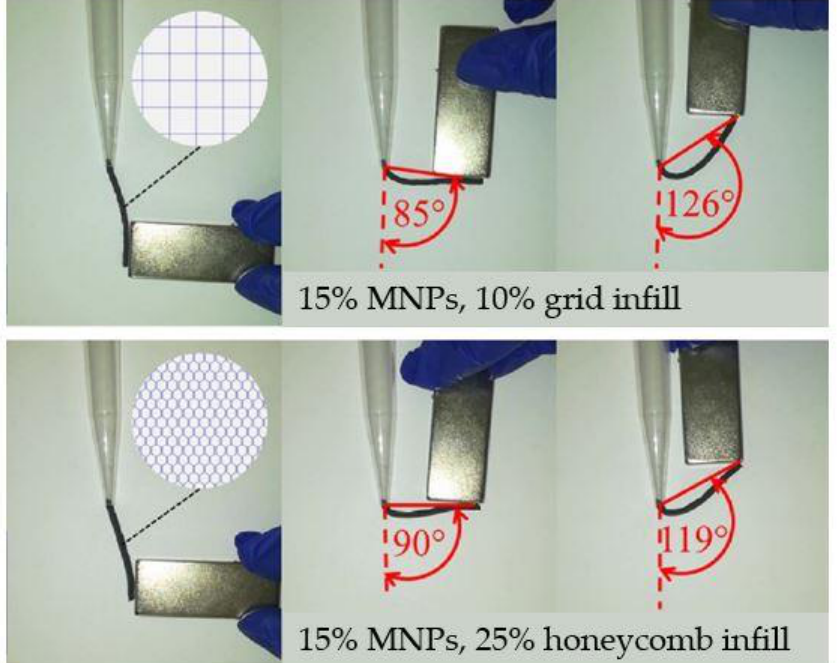
Figure 7. A magnetically actuated sensor based on flexible hydrogel (alginate and methylcellulose hydrogel) and magnetic nanoparticles (MNPs). The responsiveness of the sensor (measured as bending angle towards the magnet) is proportional to the concentration of the MNPs, reprinted with permission from [60].